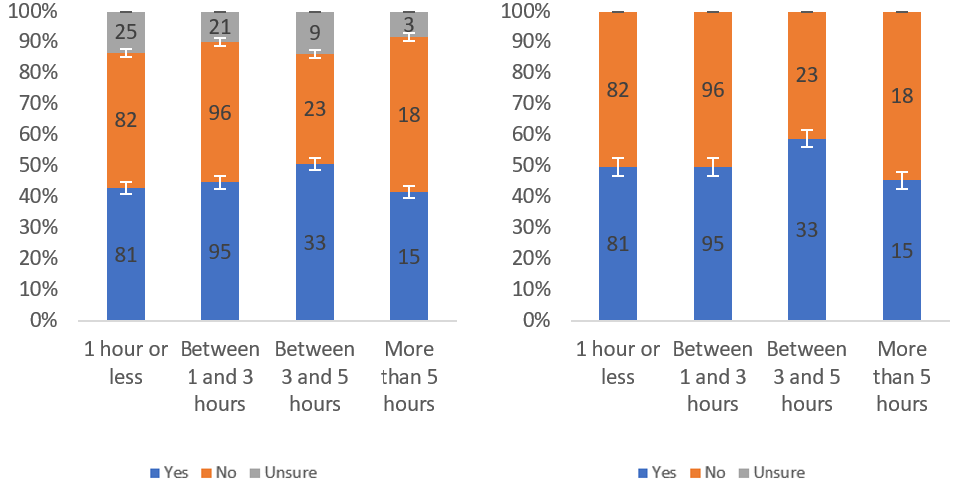
Figure A36. Responses regarding label annoyingness by internet usage level including ( left ) and excluding ( right ) unsure responses.